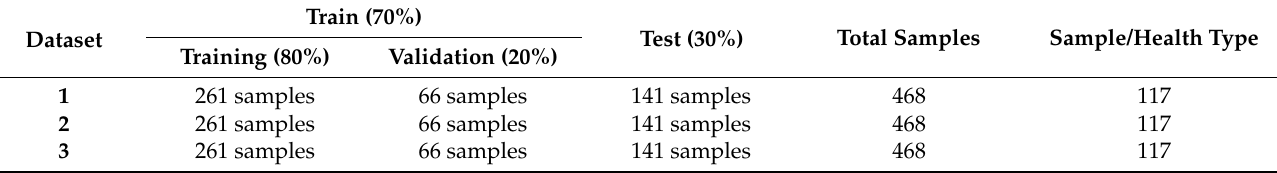
Table 4. The train, test, and validation dataset